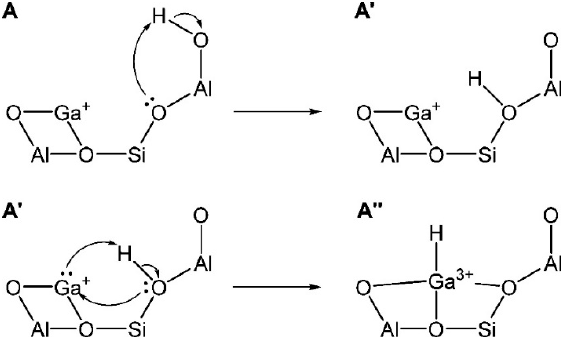
Figure 23. Two steps involved in the protonation of the Ga + by the BAS to form the active [GaH] 2+ . Reprinted with permission from ref [73]. Copyright 2018 American Chemical Society.